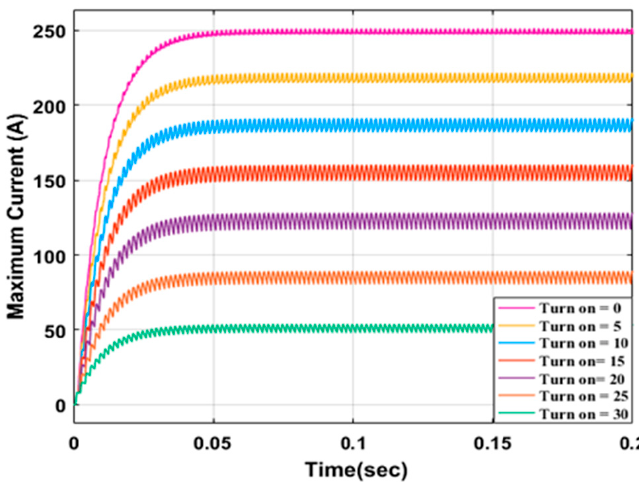
Figure 16. The generated turn-off angle control with reference current at different battery voltage.